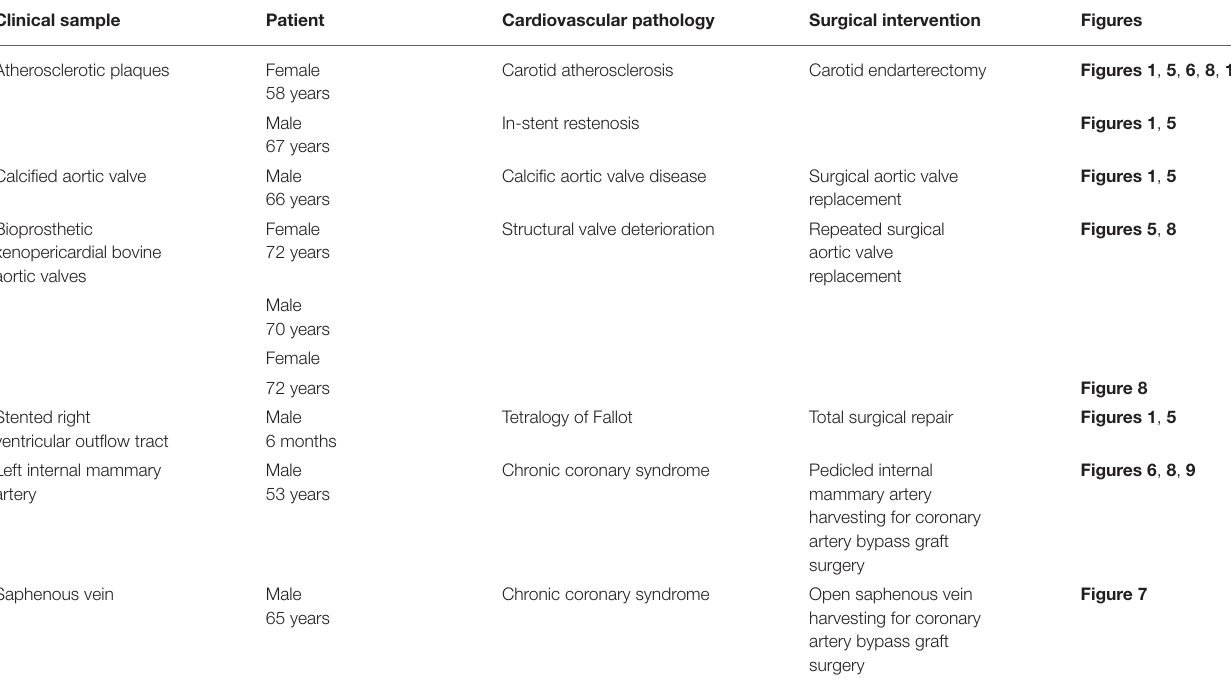
Stented right ventricular outflow